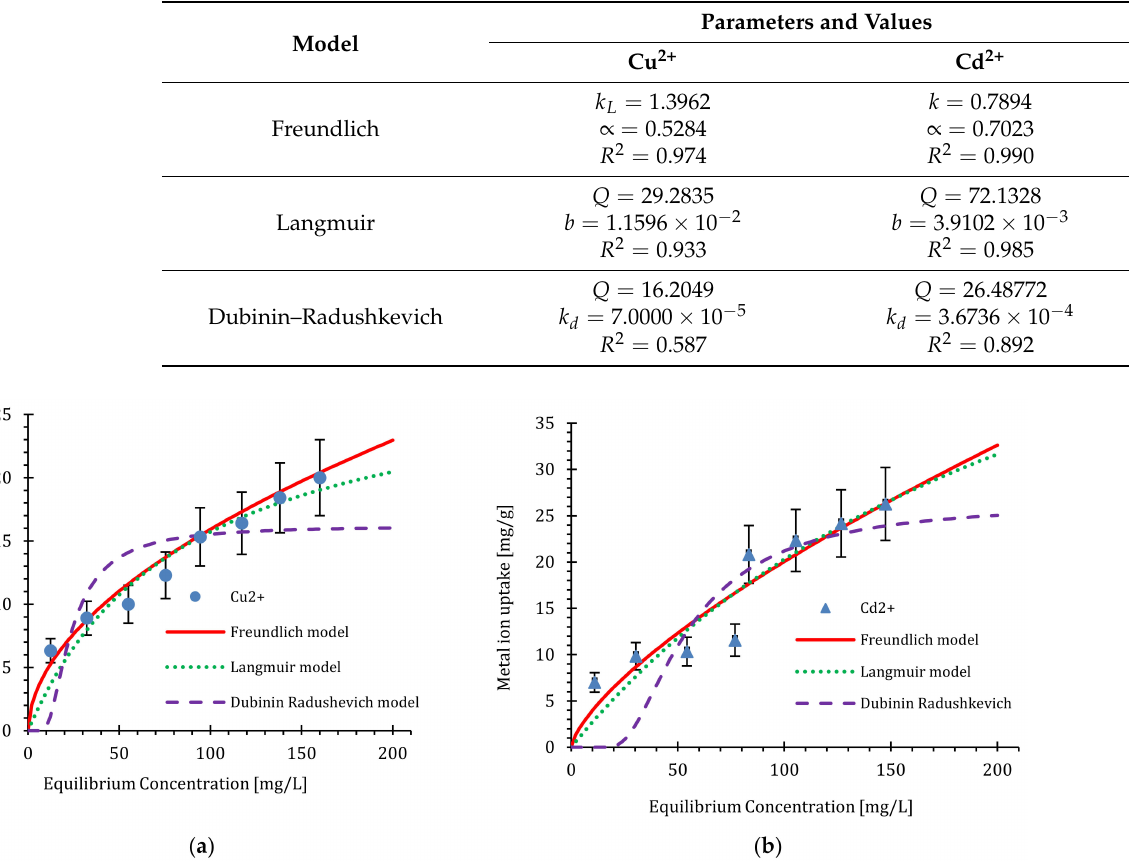
Figure 6. Adsorption isotherms of copper and cadmium ions using the nanosilica (mass of adsorbent is 0.1 g, volume of solution is 50 mL, temperature is 25 ◦ C, and equilibrium time is 72 h). Table 2. Parameters of the adsorption isotherm models.